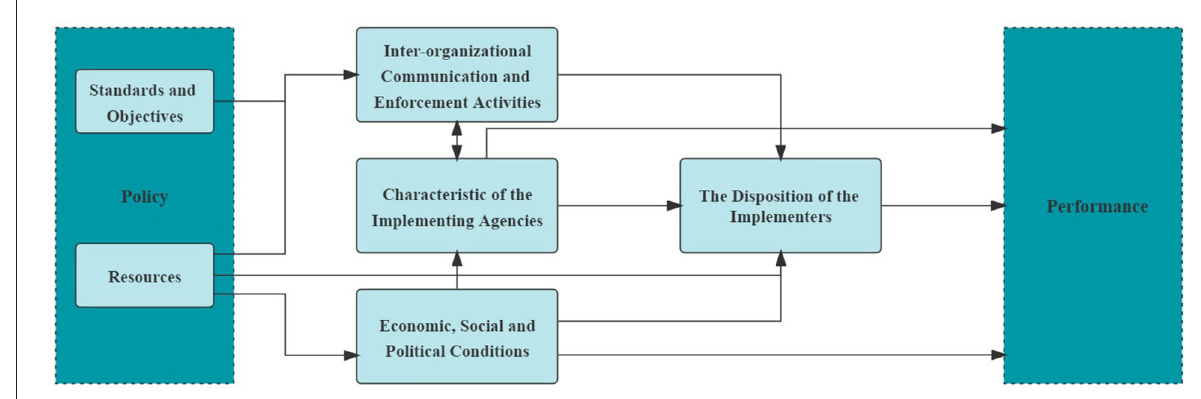
FIGURE1 The Van Meter and Van Horn top-down policy implementation approach.